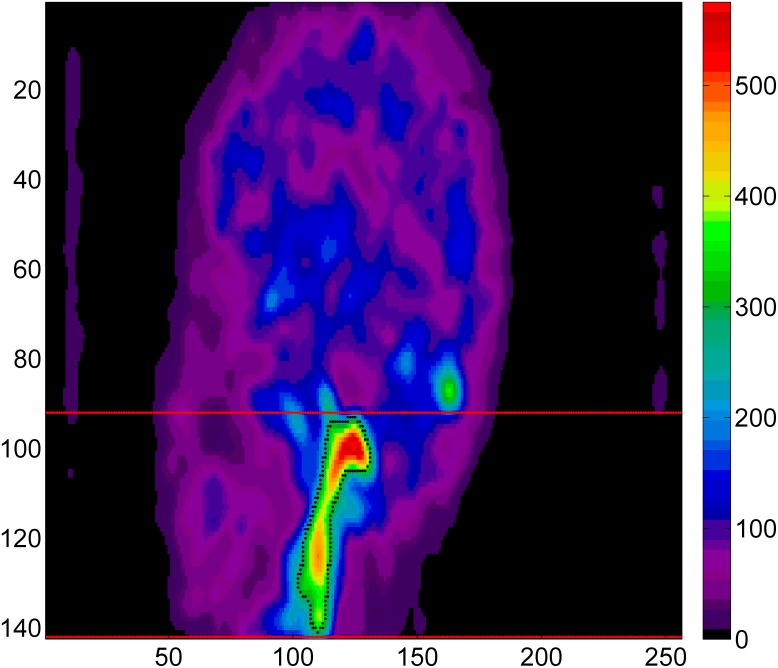
Internal carotid segmentation performed on OSEM-PSF images using automatic thresholding for one subject.The red lines illustrate the lowest 36 planes containing the internal carotid artery. The black line surrounding the carotid artery represents the automatic binary mask.